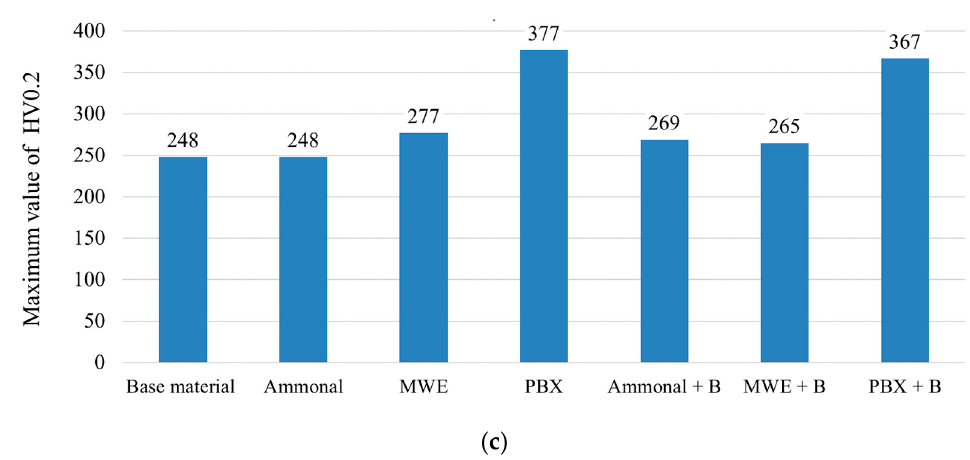
Figure 6. Distributions of microhardness obtained for samples without a steel sheet ( a ), with sa teel sheet ( b ), and the greatest strengthening obtained ( c ).